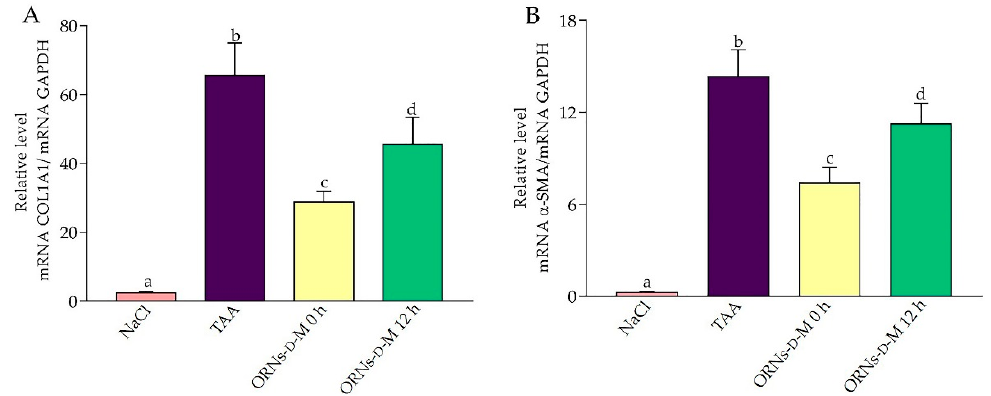
Figure 6. Effects of ORNs- D -M on the expression of COL1A1 ( A ) and α -SMA ( B ) mRNA in TAA-induced liver damage mice. The investigated mRNA levels were normalized to GAPDH as a control. Data are presented as the mean ± SD, n = 6 for each group. Values marked with different letters (a, b, c, d) are statistically different, p < 0.05 (Student’s t -test). Abbreviations: NaCl—control mice receiving